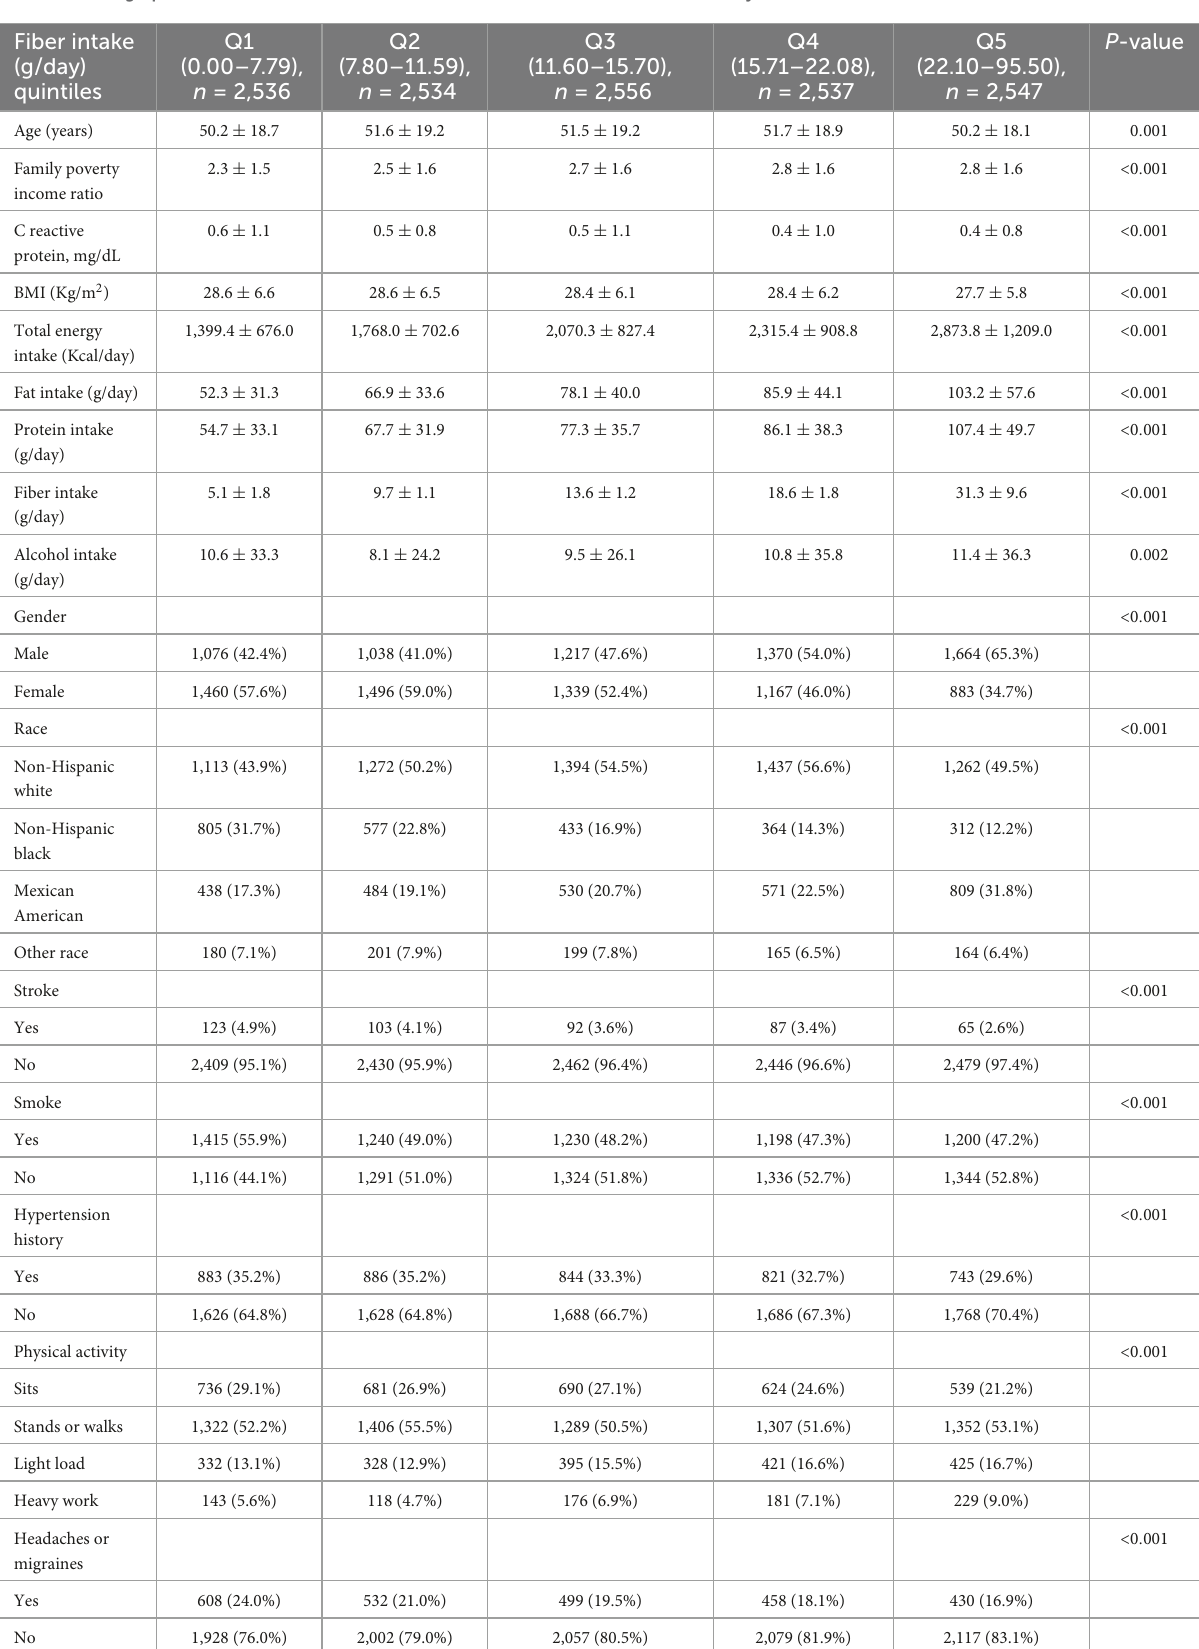
TABLE 1 Demographics for the combined National Health and Nutrition Examination Survey (NHANES) 1999–2004 (raw